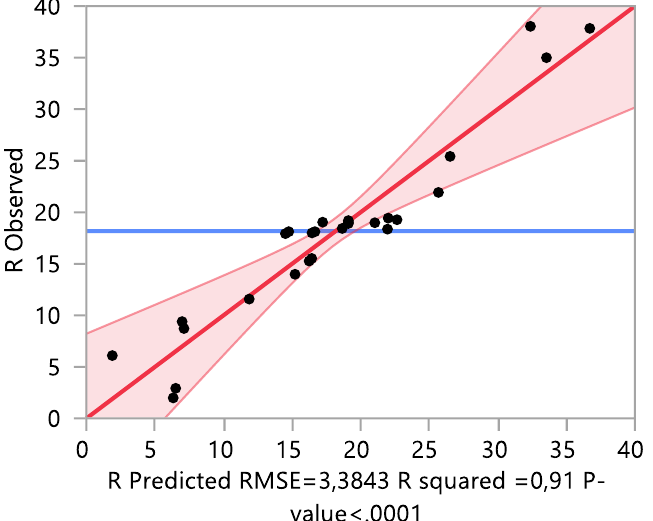
Figure 7. Relation between actual and predicted adsorbed amount of PCP on Mt-Fe-CTAB. 331